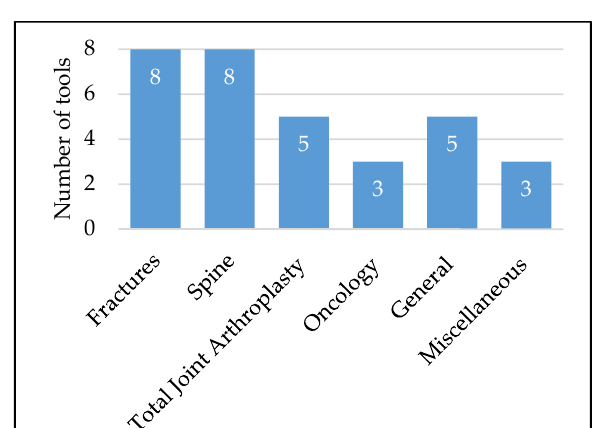
Figure 3. Tool breakdown by output.